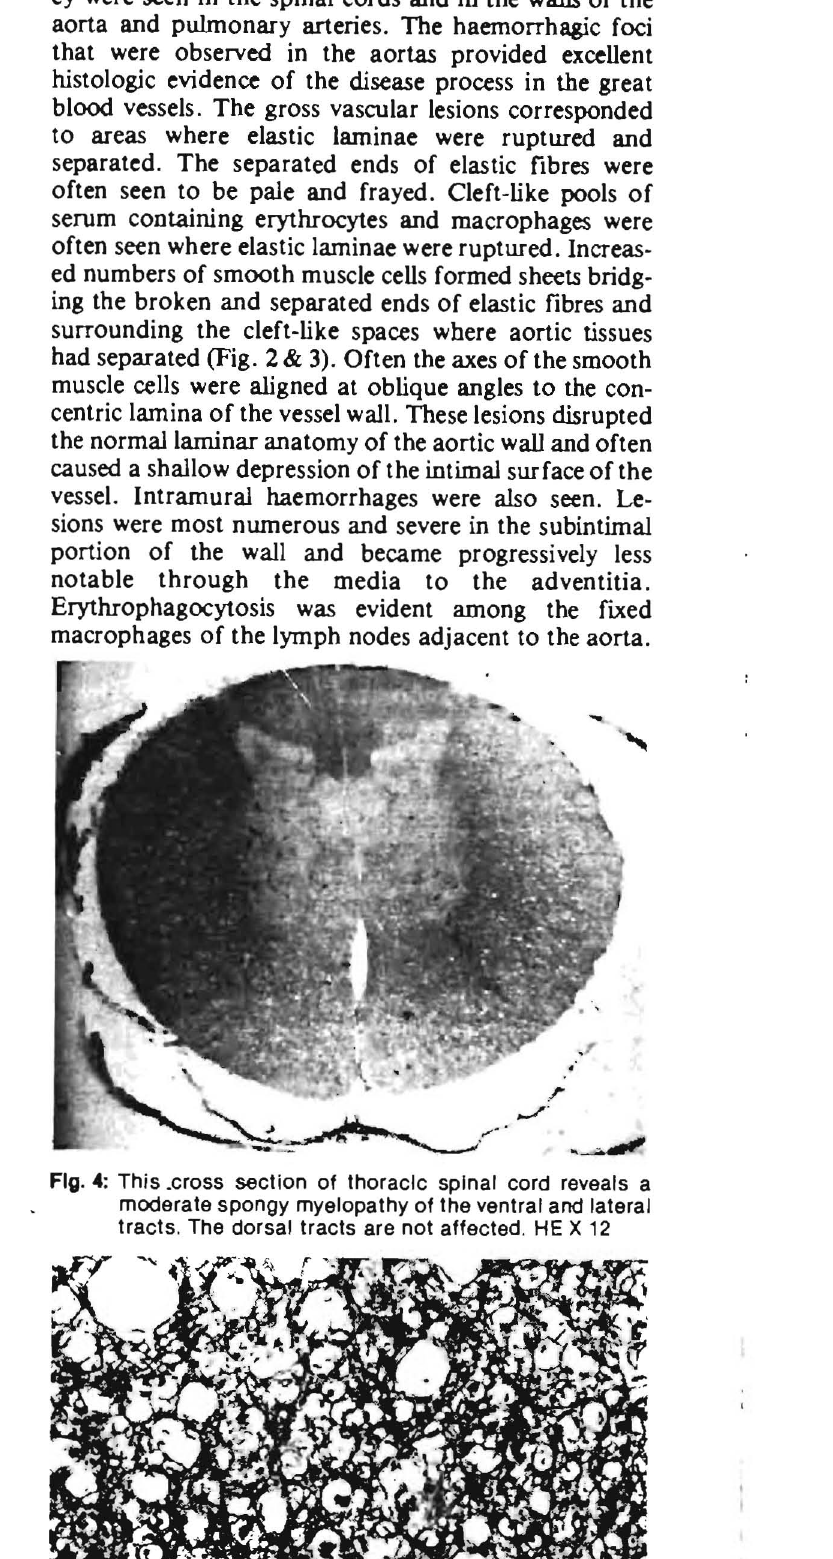
Fig. 4: This .cross section of thoracic spinal cord reveals a moderate spongy myelopathy of the ventral and lateral tracts. The dorsal tracts are not affected. HE X 12